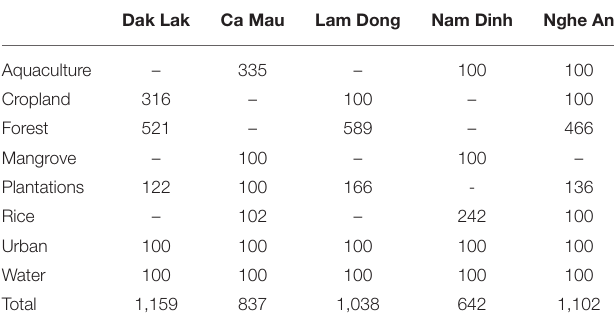
TABLE 2 | Number of validation points per